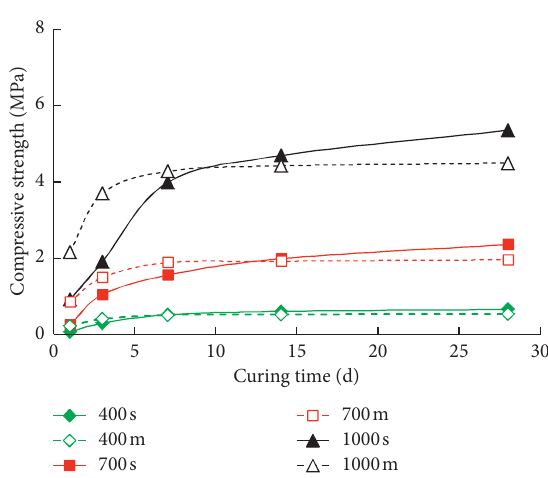
Figure 11: Relationship between compressive strength and curing time (pure cement). Note: 400 s denotes the value with the casting density of 400kg/m3 under standard curing conditions. 400 m denotes the value with the casting density of 400kg/m 3 under temperature matched curing conditions.